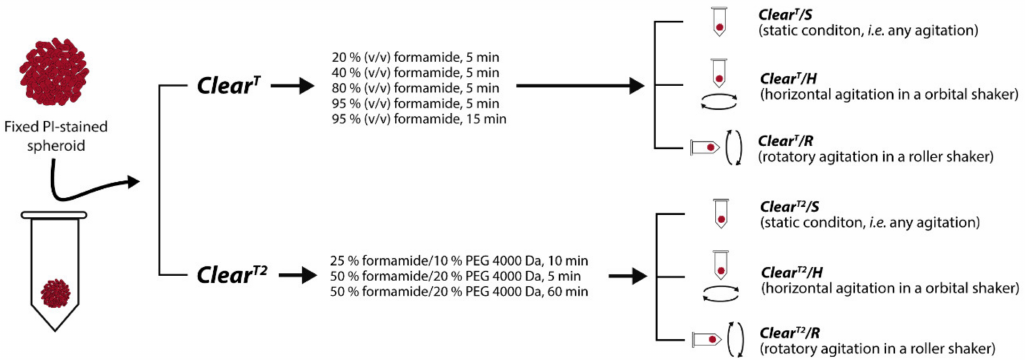
Figure 1. Overview of the PI-stained spheroids optical clearing performed through Clear T and Clear T2 using different spheroids immersion conditions, namely static, horizontal agitation, and rotatory